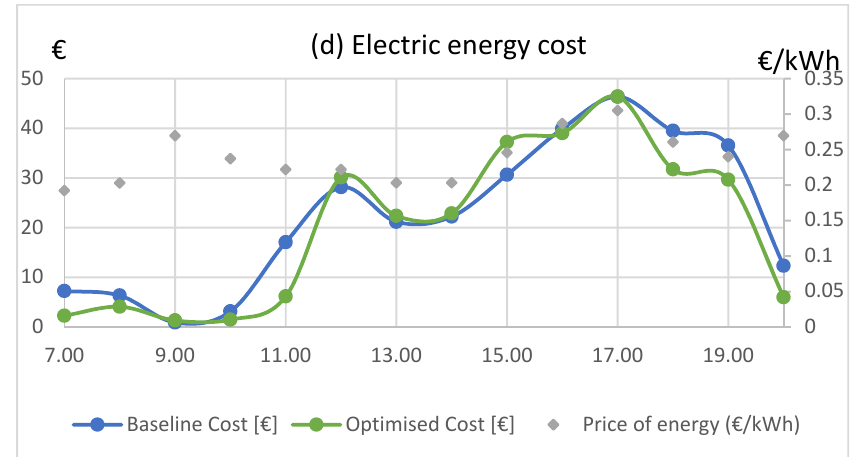
Figure 6. GA HVAC optimization results for 10 September 2018 (autumn).